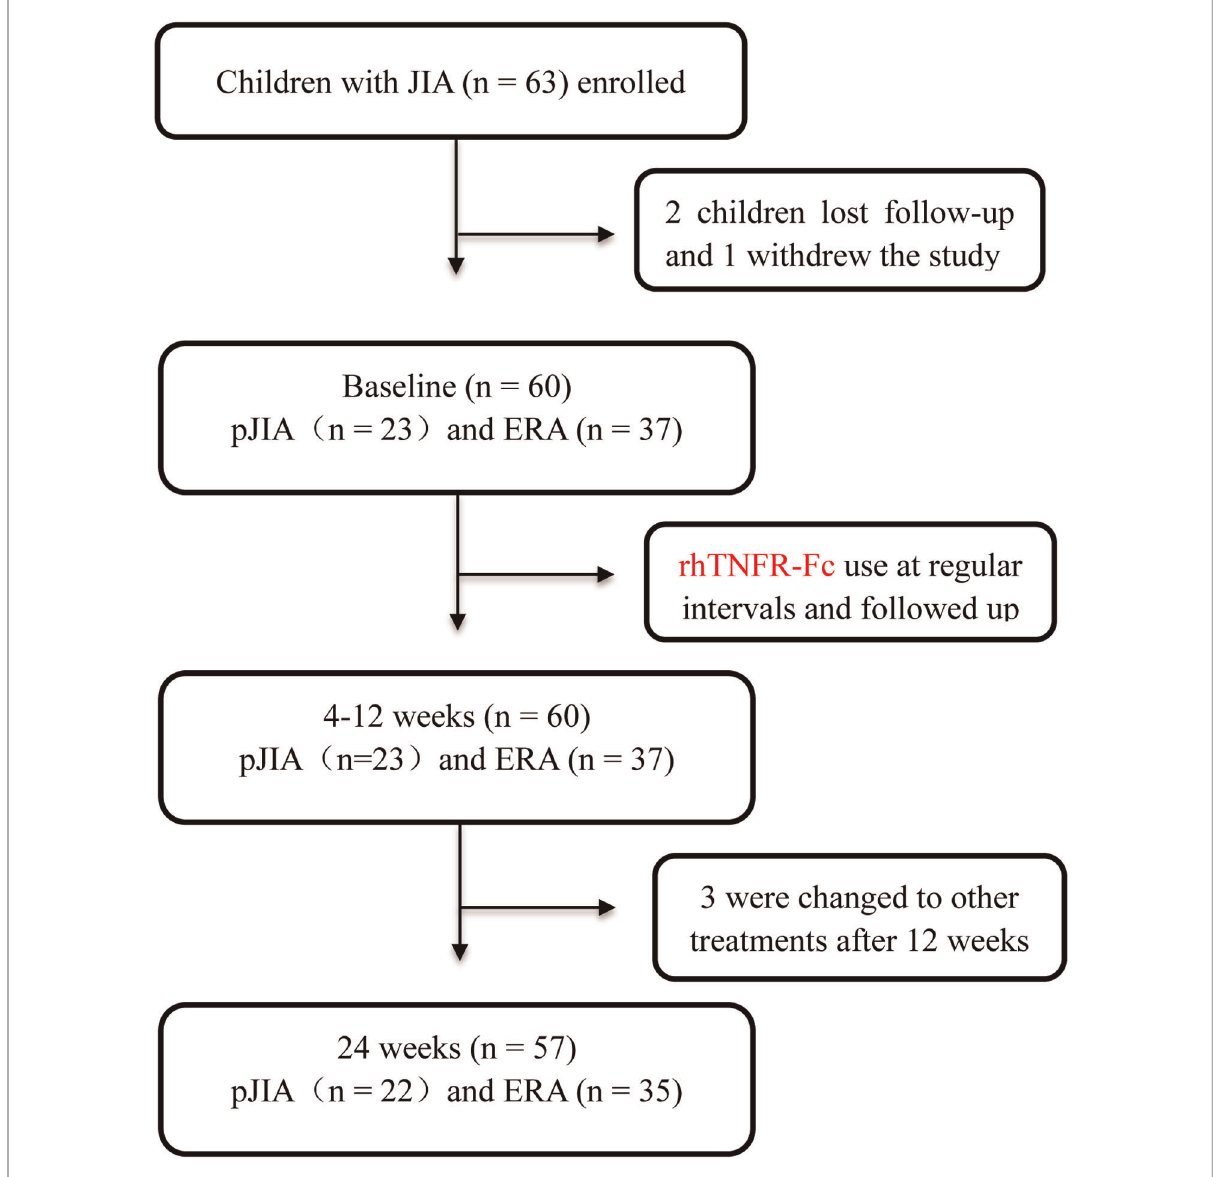
FIGURE 1 Participant selection fl owchart. JIA, juvenile idiopathic arthritis; pJIA, polyarticular course JIA; ERA, enthesitis related